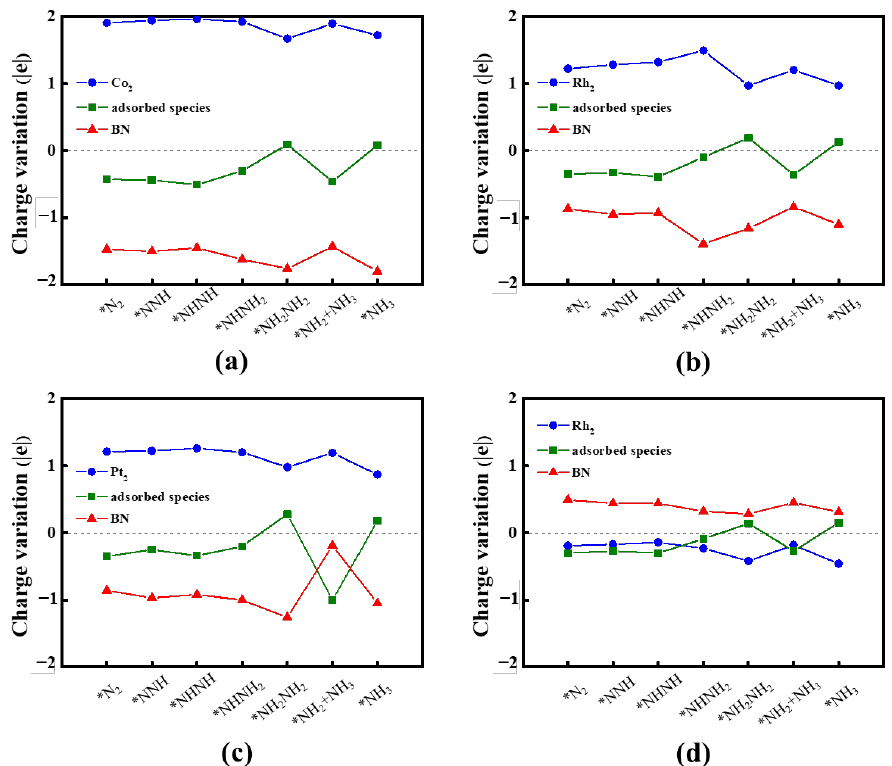
Figure 6. Charge variation of the three moieties along the enzymatic pathway on ( a ) Co 2 ⊥ vb-BN, ( b ) Rh 2 ⊥ vb-BN, ( c ) Pt 2 ⊥ vb-BN and ( d ) Rh 2 ⊥ vn-BN.